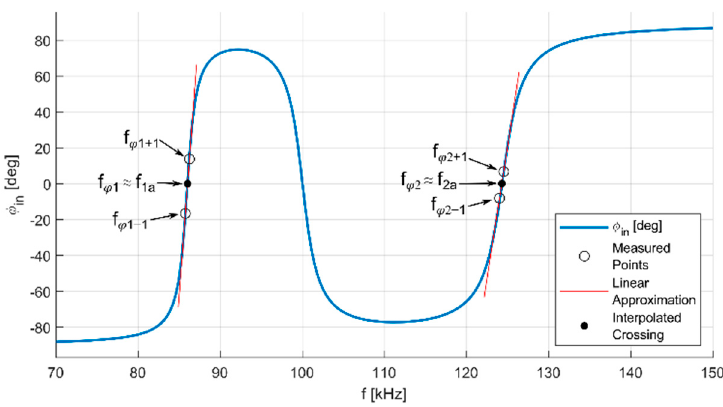
Figure 3. Frequency response of the input phase ϕ in for the IPT system in deep bifurcation, with marked measured points, linear approximation and interpolated zero crossings. Based on the circuit parameters from Table 1.